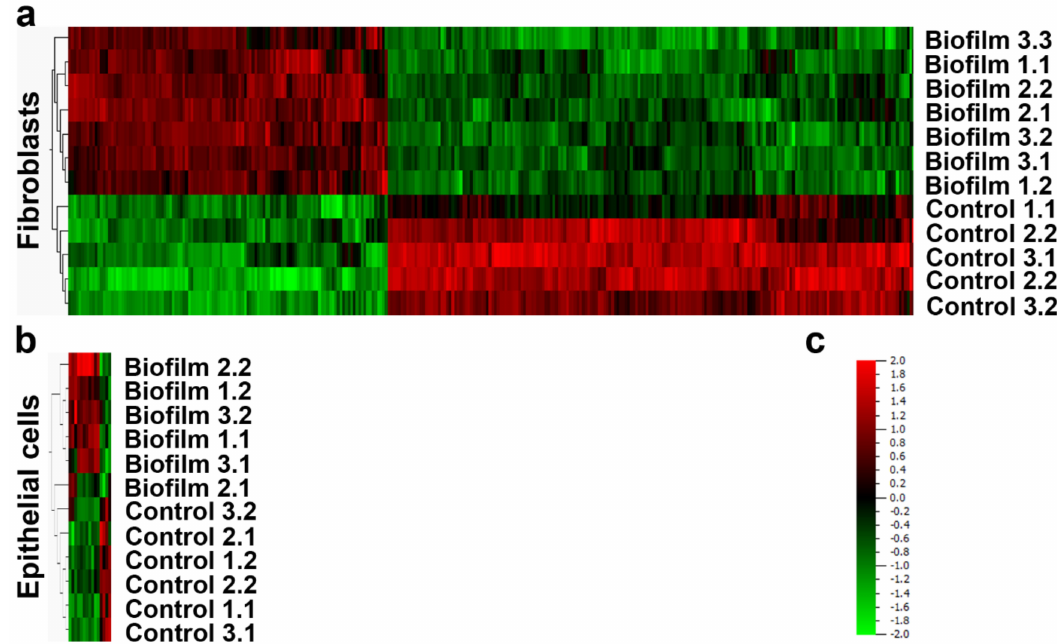
Figure 4. Transcriptional analysis of peri-implant tissue cells after 2 h challenge with S. oralis biofilm. The HGFs ( a ) showed a broader response than the HGEps ( b ). The heat-maps were generated using Qlucore Omics Explorer 3.2 after the hierarchical clustering of the experimental groups and the di ff erentially regulated genes (data from three independent experiments). The intensity of red indicates the upregulation of genes after co-culture and intensity of green downregulation ( c ). Detailed gene lists of upregulated and downregulated genes are recorded in the supplementary material (Tables S3–S6). HGF: data from three independent experiments (five control cultures and seven co-cultures). HGEp: data from three independent experiments (six control cultures and six